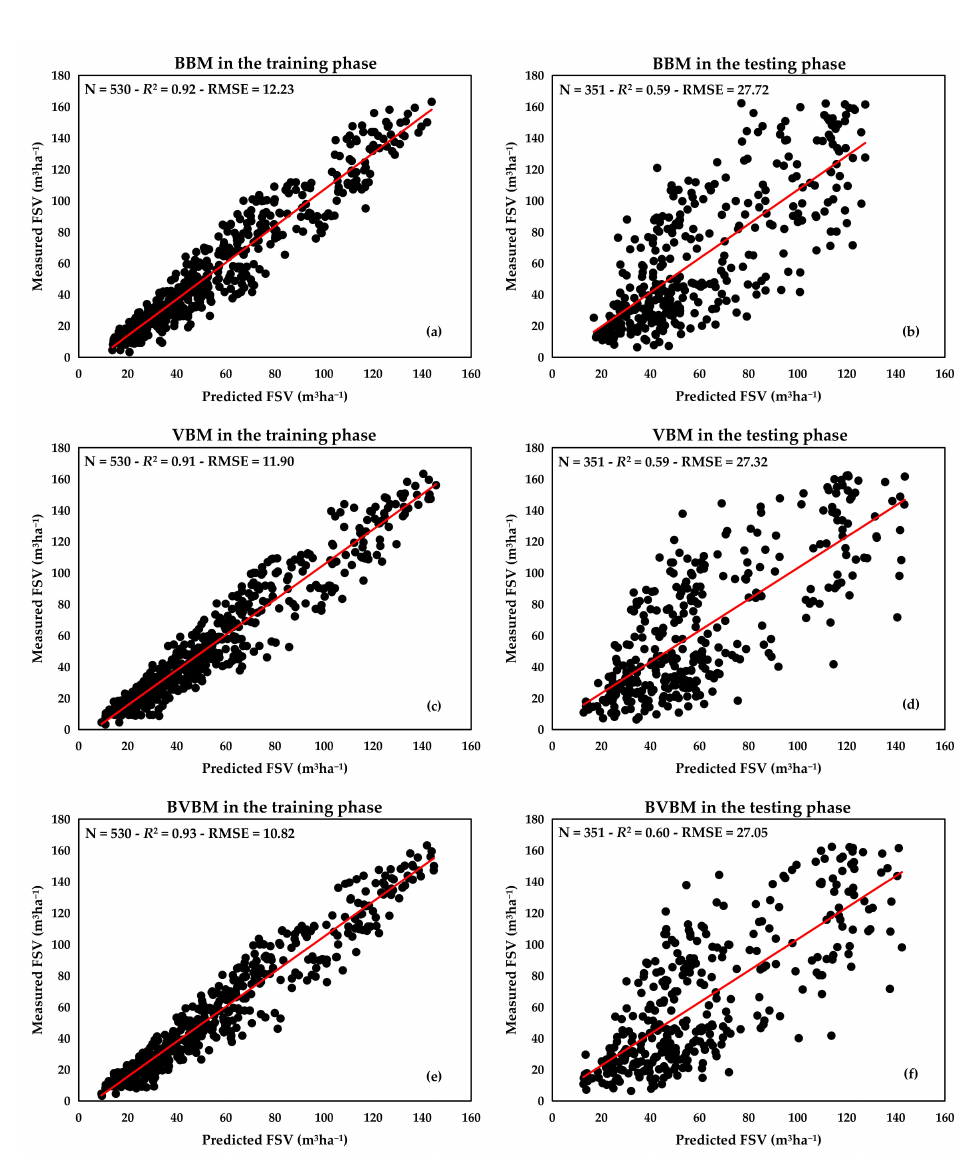
Figure 8. Comparison of the measured FSV and predicted FSV by the three models. ( a ), BBM in the training phase. ( b ), BBM in the testing phase. ( c ), VBM in the training phase. ( d ), VBM in the testing phase. ( e ), BVBM in the training phase. ( f ), BVBM in the testing